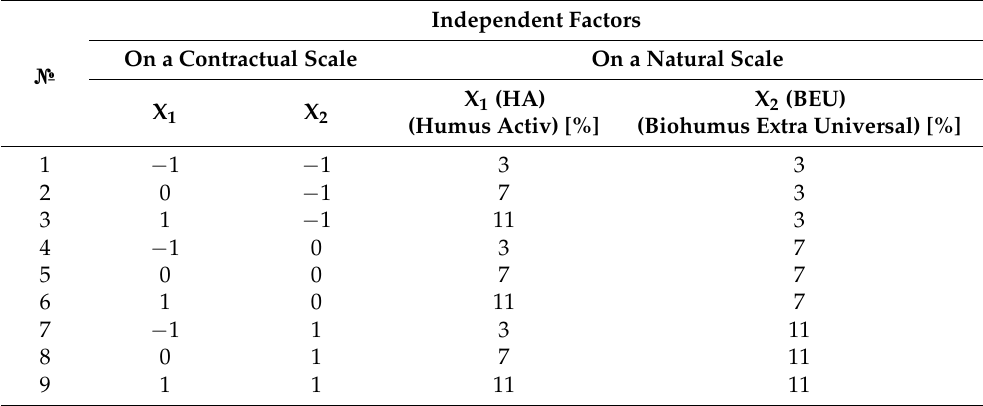
Table 3. Experiment planning matrix and levels of independent factors.